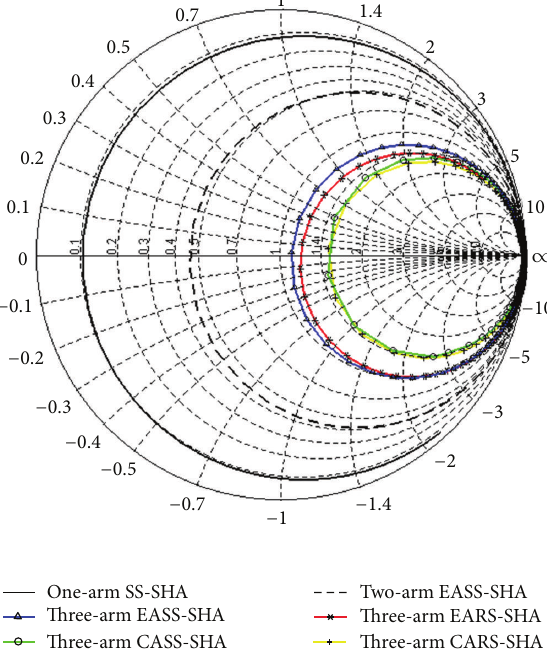
Figure 5: The Smith impedance diagram (normalized to 50 Ω ) of one-, two-, and three-arm PEC SHAs.